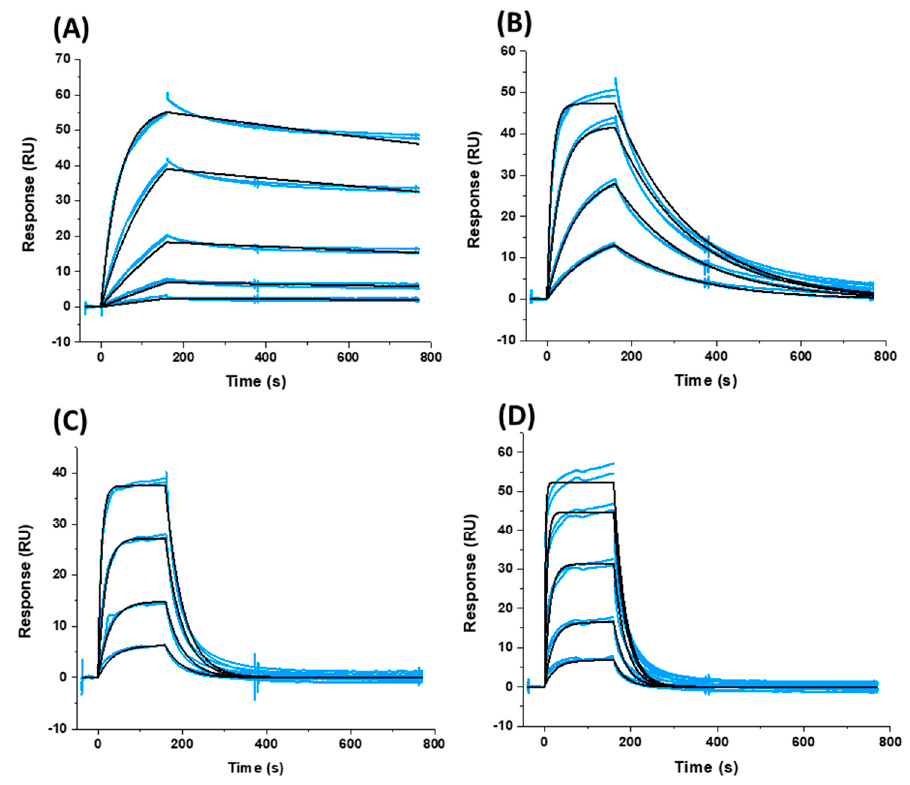
Figure 2. Sensorgrams depicting the interaction of ( A ) SC11 , ( B ) SC16 , ( C ) SC18 , and ( D ) SC39 with sensor chip-immobilized B41 SOSIP.664 gp140 trimer. Blue lines represent actual data, whereas black lines indicate fitting to a 1:1 interaction model. Each panel shows two injections at each concentration to demonstrate